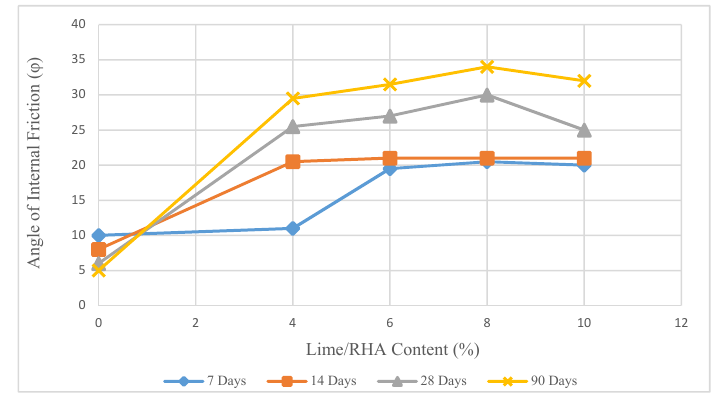
Figure 13. Internal friction angle in treated soil with LRHA 1:1.